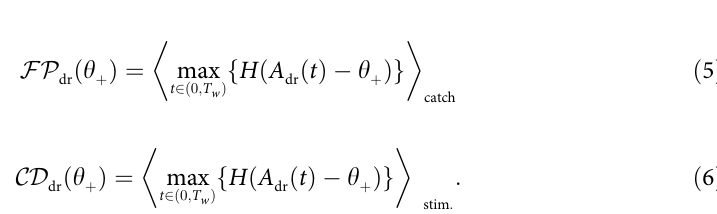
Fig 2C. The differentiator network readout (DNR) consists of two populations: one readout population of 10000 RS neurons ( S B ) and one population of 2000 FS inhibitory neurons ( I ). Each neuron within both populations receives the same number of feed-forward input connec- tions from the three populations of the BCN as the size of the readout set of the respective cell type. More precisely, each neuron in the DNR receives input from N RS ¼ 1000 randomly read chosen RS neurons, N FS ¼ 100 randomly chosen FS neurons, and N SOM ¼ 100 randomly read read chosen SOM neurons. Neurons in the readout population S B evolve according to the same dynamical equation as RS neurons of the BCN, while neurons in I follow the same dynamical